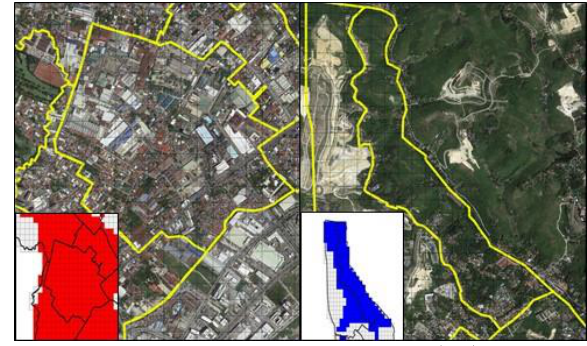
Figure 10. Grid analysis on barangay Tipolo (left) with 100% hotspot pixel count and barangay Casili (right) with 100% coldspot pixel